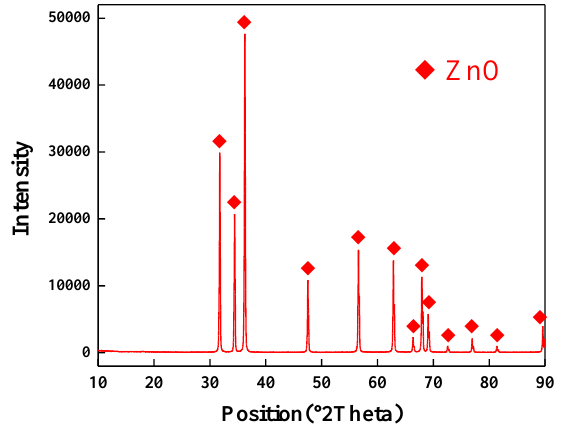
Figure 9. XRD pattern of ZnO product.